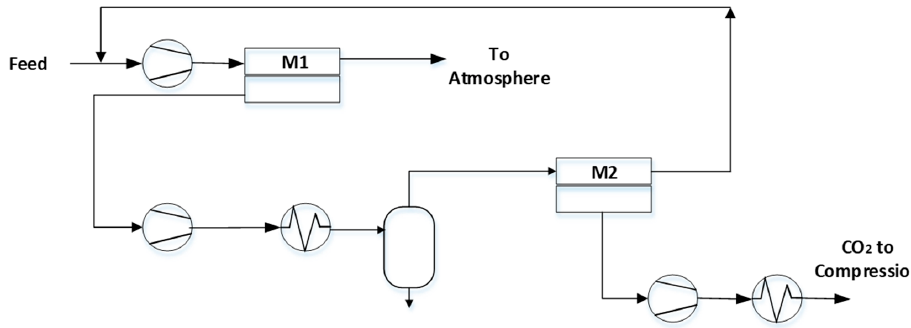
Figure 3. Simplified PFD of S/D technology for carbon capture considered in the simulation. Even in this case, the concentrated CO 2 after the membrane process is compressed to 110 bara.